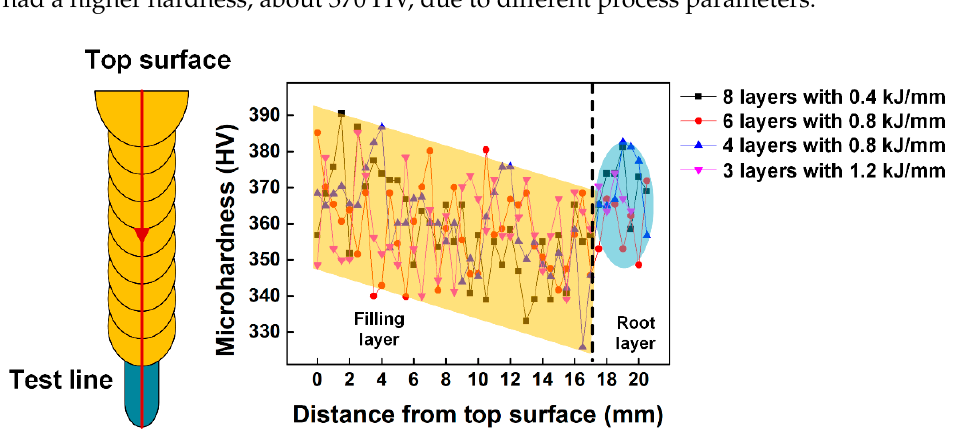
Figure 6. Microstructure and EBSD analysis results of different samples. ( a – d ) A total of 8 layers with 0.4 kJ/mm; ( e – h ) 4 layers with 0.8 kJ/mm; ( i – l ) 3 layers with 1.2 kJ/mm.